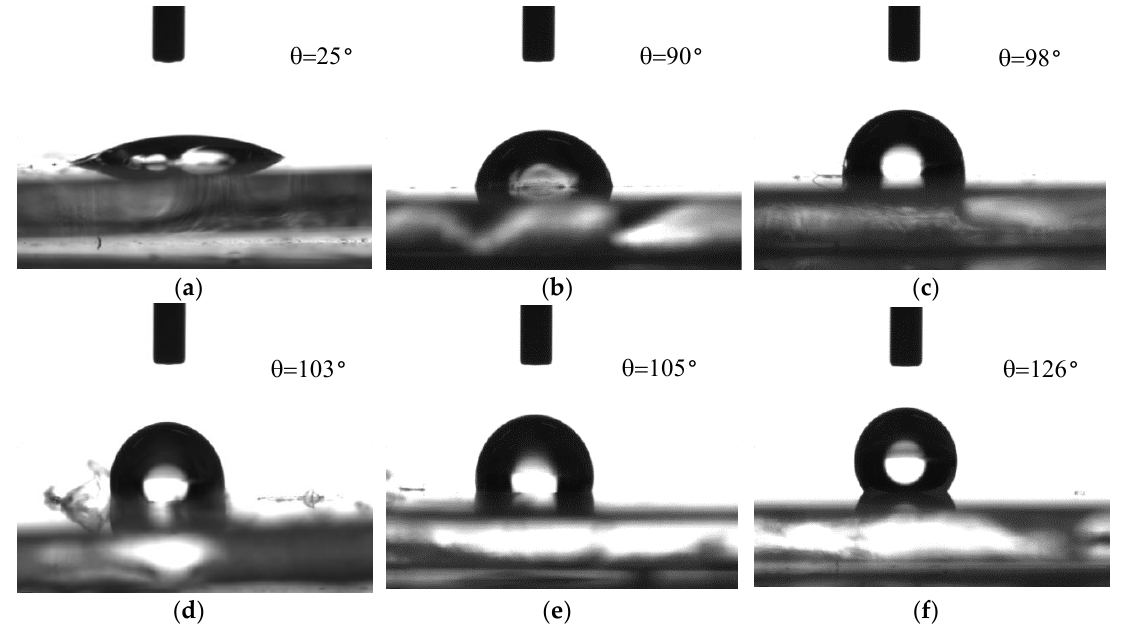
Figure 5. Water drop contact angle profile for: ( a ) clear glass, ( b ) (PAC 18 Na/PDADMAC) 20 , ( c ) (PAC 18 Na- C 10 TAB/PDAMAC) 20 , ( d ) (PAC 18 Na-C 12 TAB/PDAMAC) 20 , ( e ) (PAC 18 Na-C 14 TAB/ PDAMAC) 20 and ( f ) (PAC 18 Na-C 18 TAB/PDAMAC) 20 multilayer films exposed to E. coli ATCC 25922.